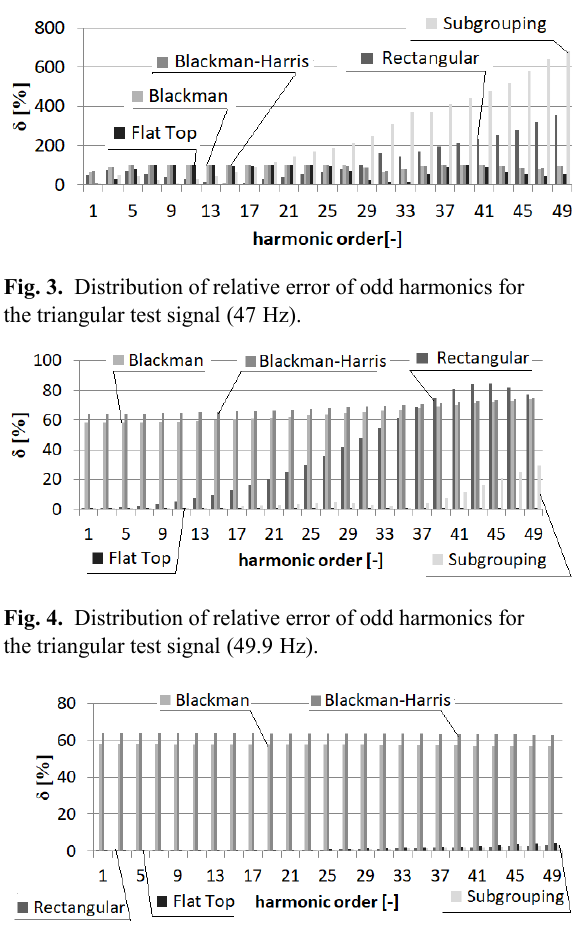
Fig. 5. Distribution of relative error of odd harmonics for the triangular test signal (50 Hz).